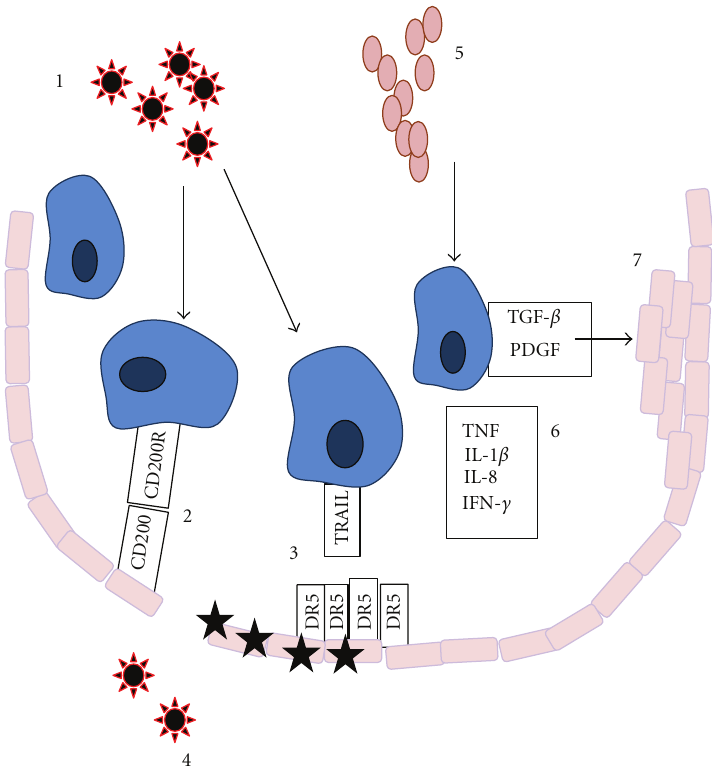
Figure 1: Alveolar macrophage-mediated disease in the lung. AMs are the dominant cell type in the uninfected airway. Following virus infection (1), AMs are restrained from overreacting and inducing bystander damage to tissues by the CD200R on their surface (2) which induces a negative signalling cascade. (3) Pandemic influenza strains induce the upregulation of TRAIL on the AM surface and of its receptor DR5 on the alveolar epithelial cells, which leads to increased apoptosis in the epithelium and consequent morbidity. Both the presence of TRAIL and the absence of CD200R can induce epithelial damage and spread of virus out of the alveolus (4). Bacterial infection (5) induces AM to produce inflammatory cytokines (6), leading to activation of bystander cells and tissue damage. AMs are also triggered to produce growth factors (7) which leads to epithelial hyperplasia, deposition of ECM and fibrosis.